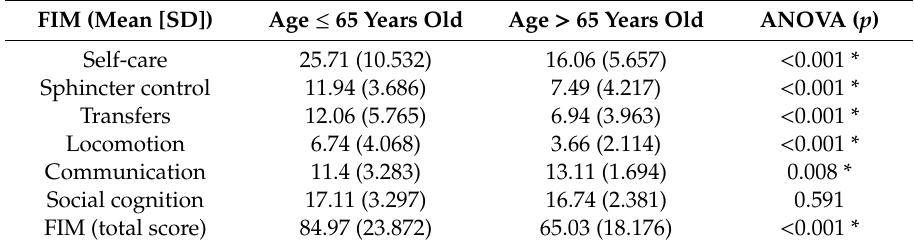
Table 2. FIM scores in two groups of patients younger and older than 65